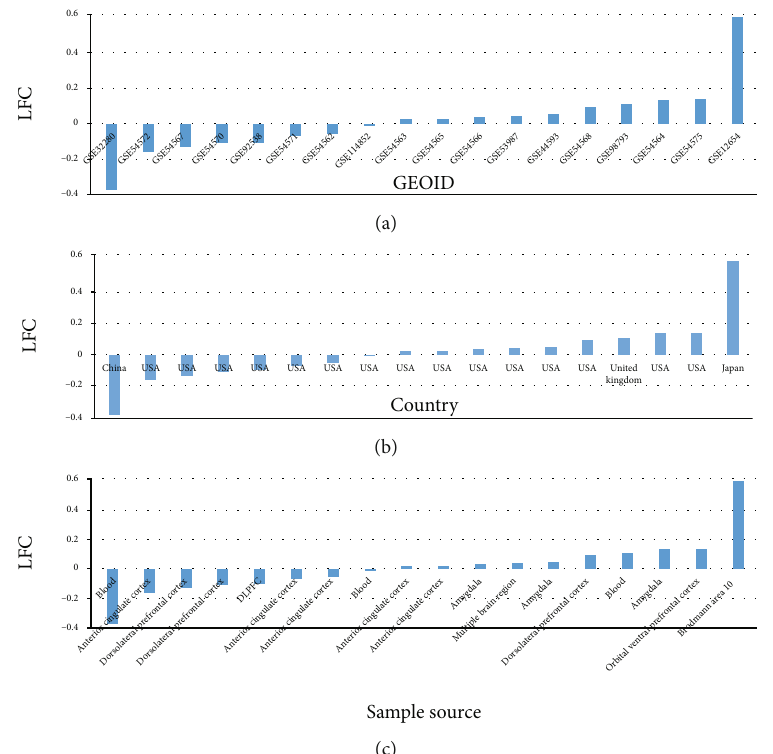
Figure 2: Expression of PPARD in 18 MDD RNA expression datasets: (a) the expression by datasets; (b) the expression by country; (c) the expression by sample source.